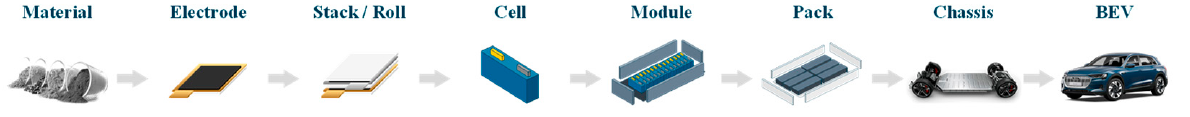
Figure 1. Simpli fi ed BEV product structure based on a conventional ba tt ery system architecture. Figure 1. Simplified BEV product structure based on a conventional battery system